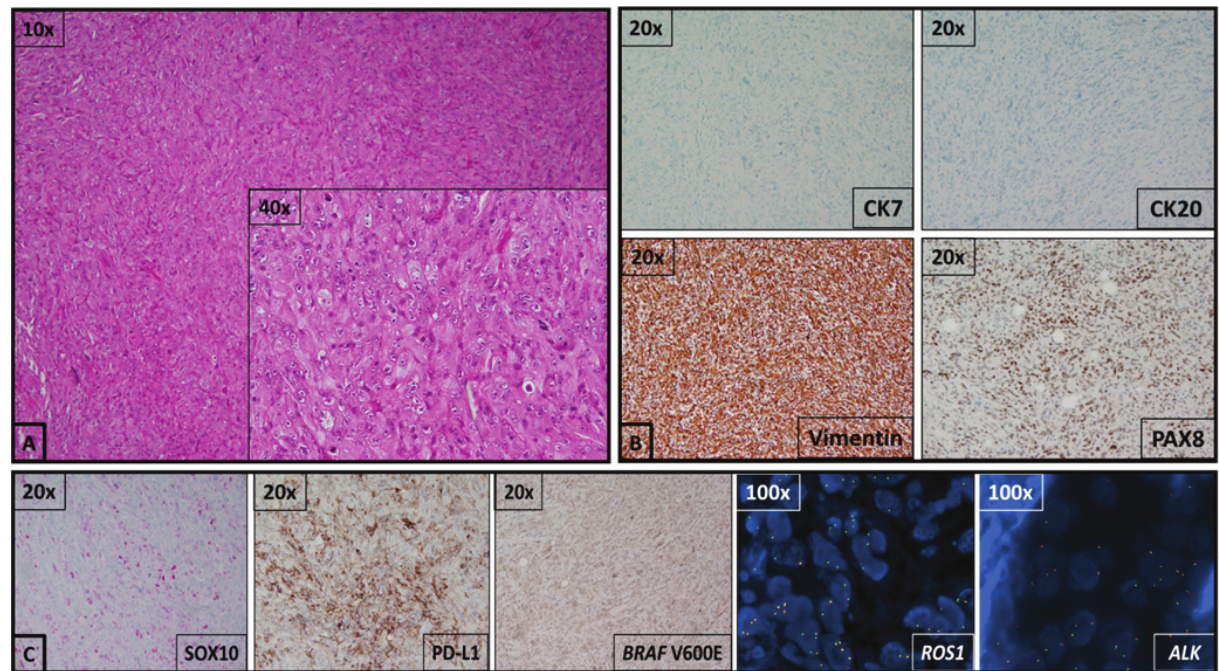
Figure 3. A diagnostic challenge. (A) On hematoxylin–eosin staining, this excisional biopsy demonstrates a lymph node that has been entirely replaced by a high-grade, eosinophilic, homogeneously sarcomatoid malignancy with no evidence of differenti- ation. There is a high degree of both cellular atypia, ranging from spindled cells to fried egg cells, and nuclear atypia, featur- ing vesicular chromatin, irregular nuclear borders, and prominent nucleoli. A portion of this tissue was sent for flow cytometry prior to microscopic analysis, which excluded a hematologic malignancy, as no significant lymphoid population was identified. (B) Immunostaining to identify the tissue of origin for this malignancy demonstrated tumor cell nonreactivity for cytokeratins 7 and 20, with reactivity for vimentin and PAX8. These immunohistochemical and morphological findings are most consistent